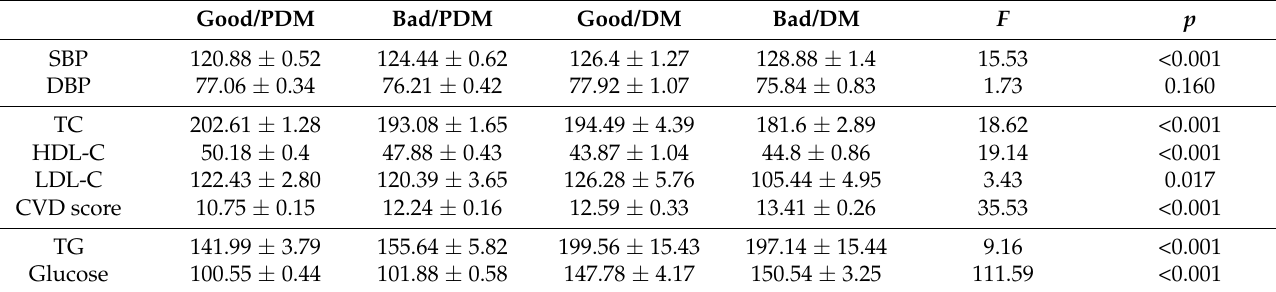
Figure 1. Health behavior practice rates between groups. Table 3. Blood pressure and blood indices between